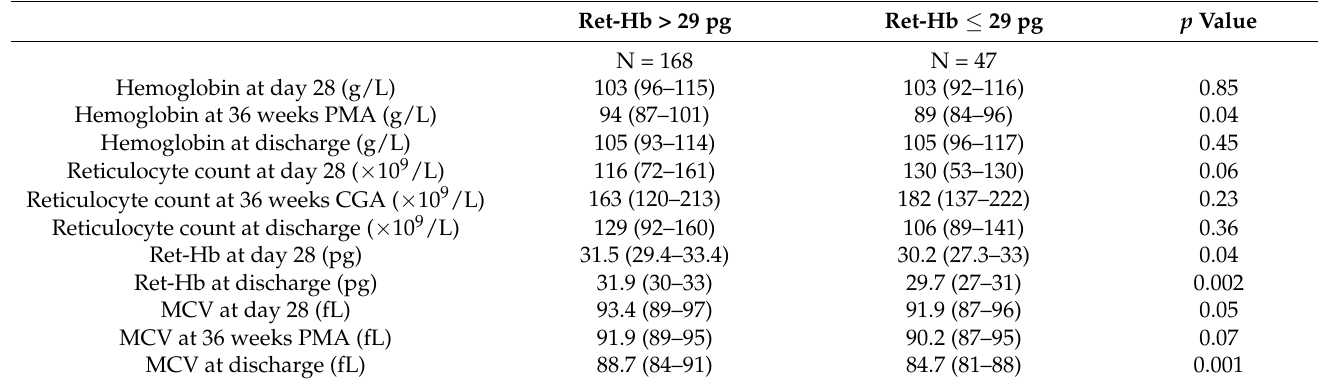
Table 2. Comparing ancillary hematological parameters between neonates who meet and do not meet criteria for iron deficiency at 36 weeks corrected gestational